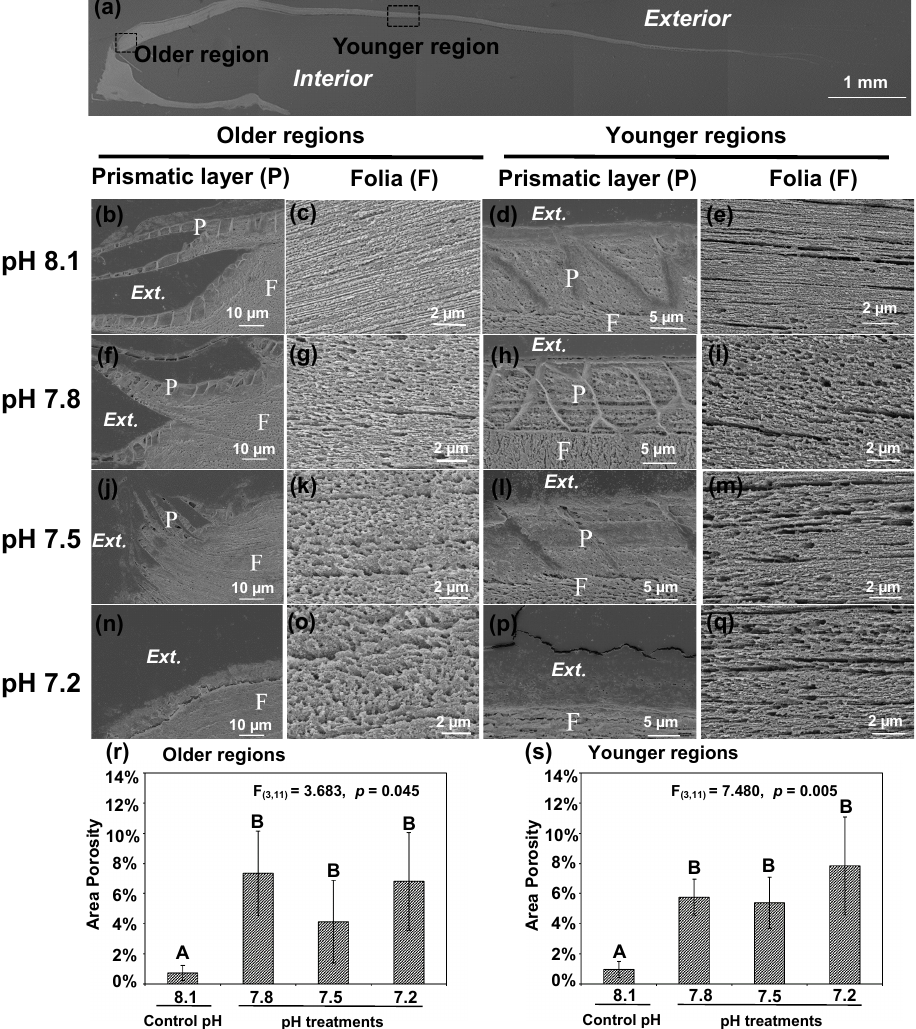
Figure 3. Microstructures were observed in the cross-sectional shell surfaces of 35-day-old juvenile Magallana angulata . Scanning electron micrographs were taken near the older hinge region (b, c, f, g, j, k, n, o) and the younger middle region (d, e, h, i, l, m, p and q) . Panel (a) shows the scanning electron micrograph of the full shell cross-sectional surface. Second row: the prismatic layer (b, d) and tightly packed foliated structure (c, e) at pH 8.1. Third row: the prismatic layer (f, h) and the foliated structure with more and bigger pores (g, i) at pH 7.8 compared with at pH 8.1. Fourth row: the incomplete prismatic layer (j, l) and more porous foliated structure (k, m) at pH 7.5 compared with at pH 8.1. Fifth row: the prismatic layer was not detectable (n, p) with porous foliated structure (o, q) at pH 7.2. The porosity of foliated layers at the older (r) and younger regions (s) of the shell reared under control and low pH treatments. The mean values are presented in the bar chart (mean ± SD, n = 3–4). Annotations: P is the prismatic layer; F is the foliated